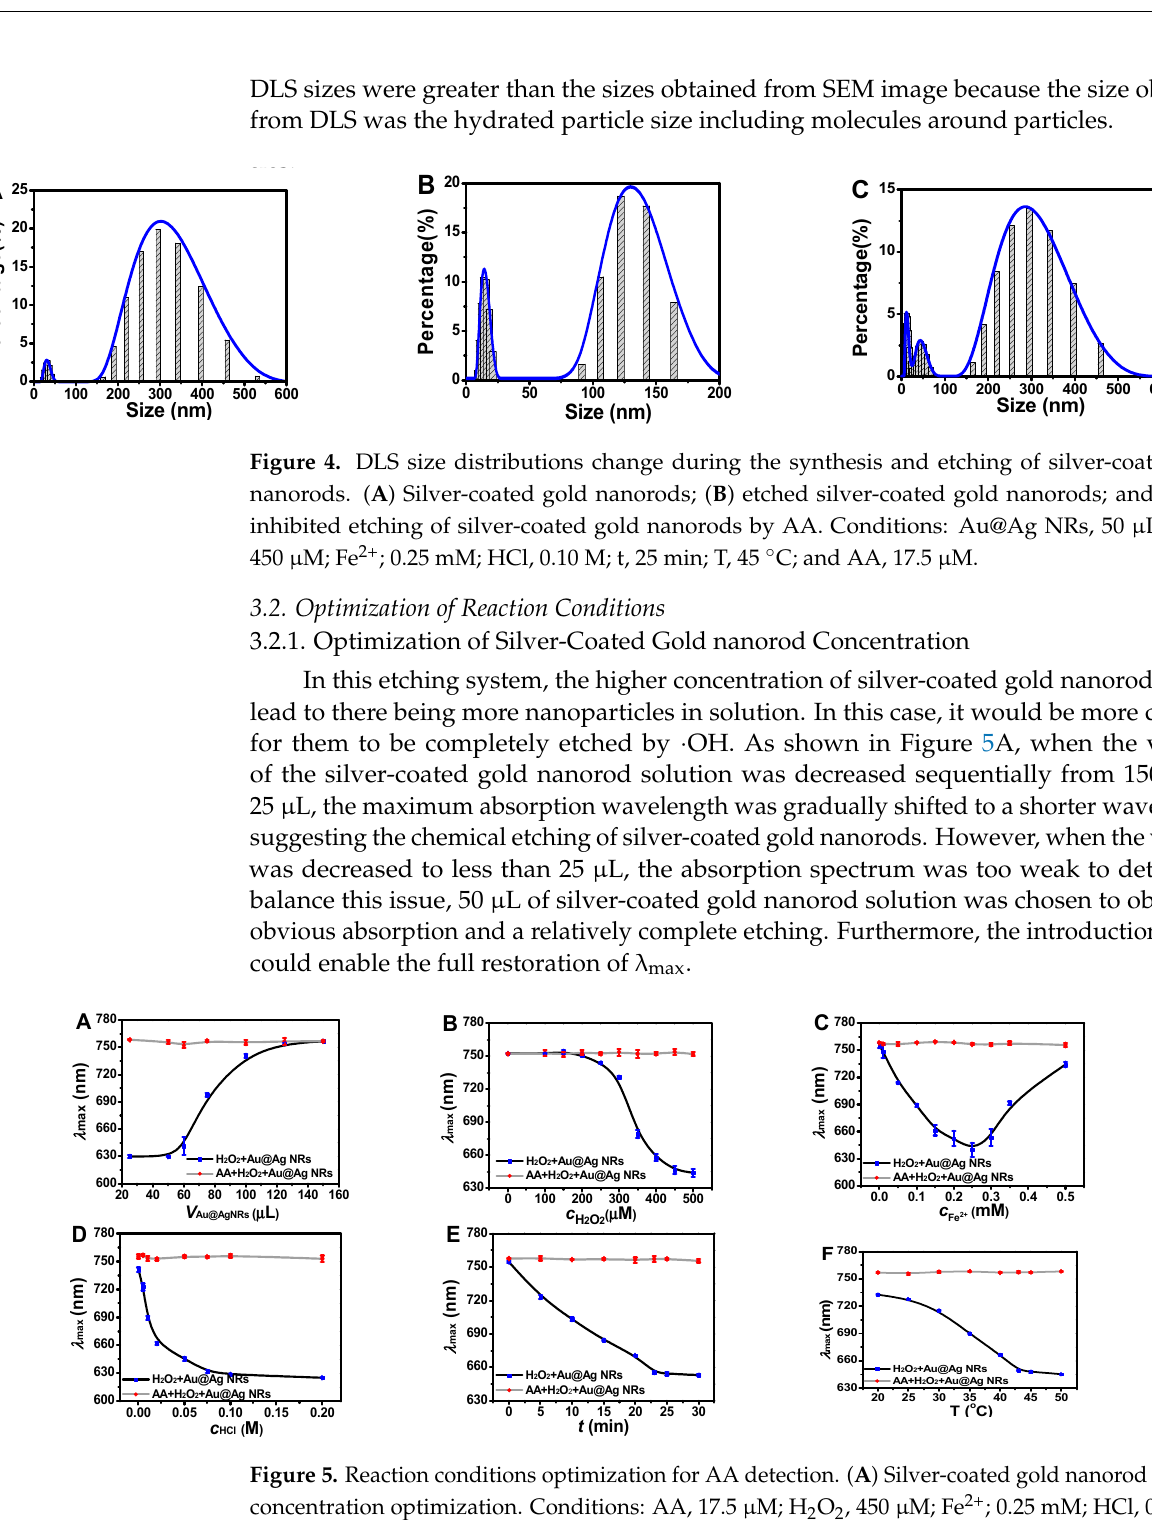
Figure 5 . Reaction conditions optimization for AA detection. ( A ) Silver-coated gold nanorod solu- tion concentration optimization. Conditions: AA, 17.5 μ M; H 2 O 2 , 450 μ M; Fe 2+ ; 0.25 mM; HCl, 0.10 M; t, 25 min; and T, 45 °C. ( B ) Hydrogen peroxide concentration optimization. Conditions: AA, 17.5 μ M; Au@Ag NRs, 50 μ L; Fe 2+ ; 0.25 mM; HCl, 0.10 M; t, 25 min; and T, 45 °C. ( C ) Hydrochloric acid concentration optimization. Conditions: AA, 17.5 μ M; Au@Ag NRs, 50 μ L; H 2 O 2 , 450 μ M; Fe 2+ ; 0.25 mM; t, 25 min; and T, 45 °C. ( D ) Optimization of Fe 2+ concentration. Conditions: AA, 17.5 μ M; Au@Ag NRs, 50 μ L; H 2 O 2 , 450 μ M; HCl, 0.10 M; t, 25 min; and T, 45 °C. ( E ) Reaction time optimiza- tion. Conditions: AA, 17.5 μ M; Au@Ag NRs, 50 μ L; H 2 O 2 , 450 μ M; Fe 2+ ; 0.25 mM; HCl, 0.10 M; and T, 45 °C. ( F ) Reaction temperature optimization. Conditions: AA, 17.5 μ M; Au@Ag NRs, 50 μ L; H 2 O 2 , 450 μ M; Fe 2+ ; 0.25 mM; HCl, 0.10 M; and t, 25 min.